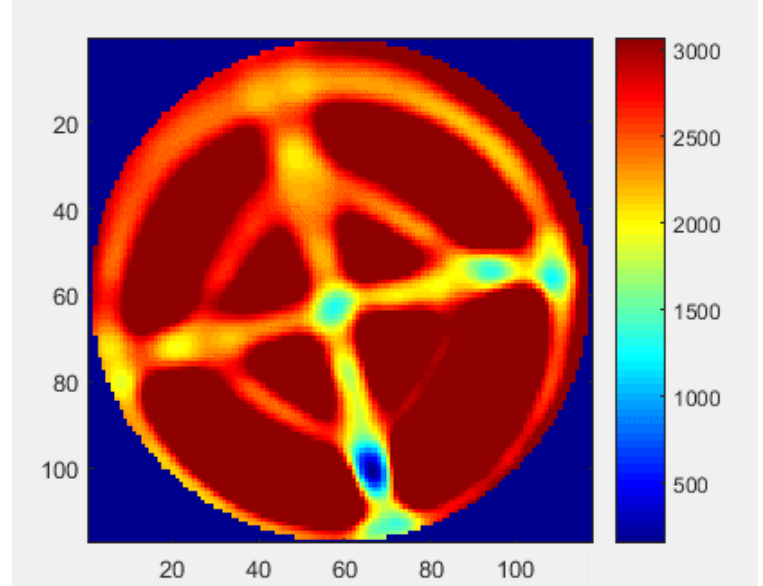
Figure 7. CT slice depicting the core and end cap boundary where the color scale reflects CT number in HU. The lighter (2000 HU range) areas reflect etching in the end caps that allows for a more distributed inflow of gas into the core. The changing CT numbers or density in these etched areas reflect the uneven contact surface between the rock and end cap. The low CT number (less dense) blue zone suggests that a void exists between end cap and core in that